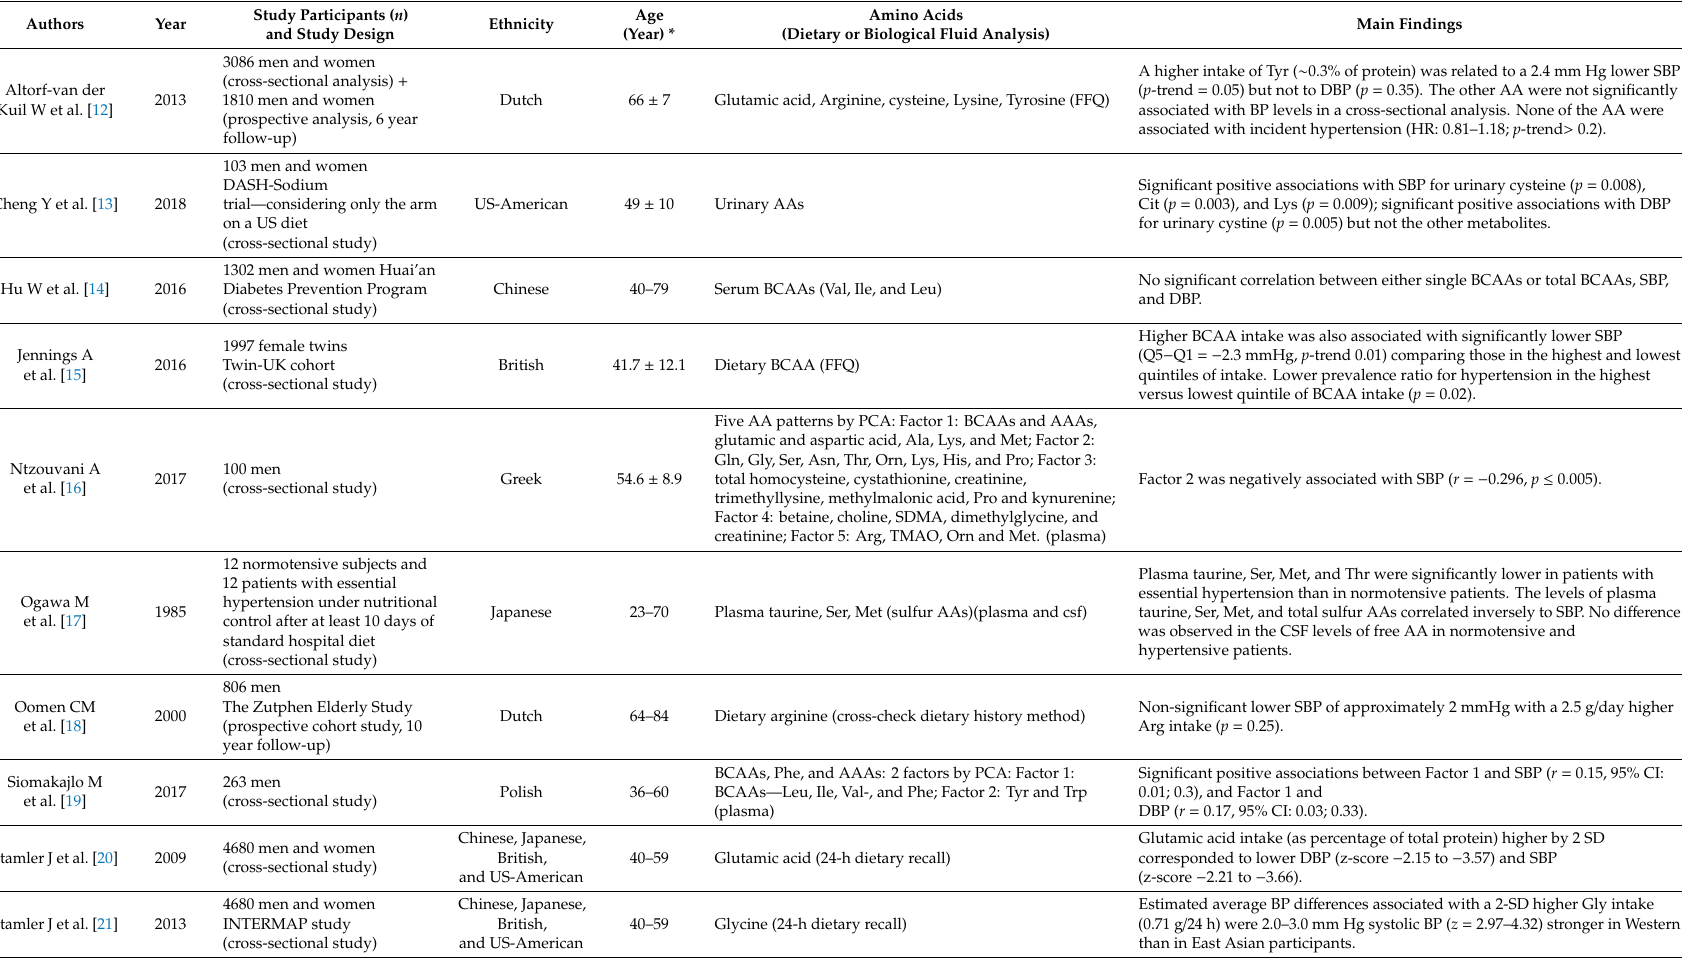
Table 1. Study characteristics and main findings.